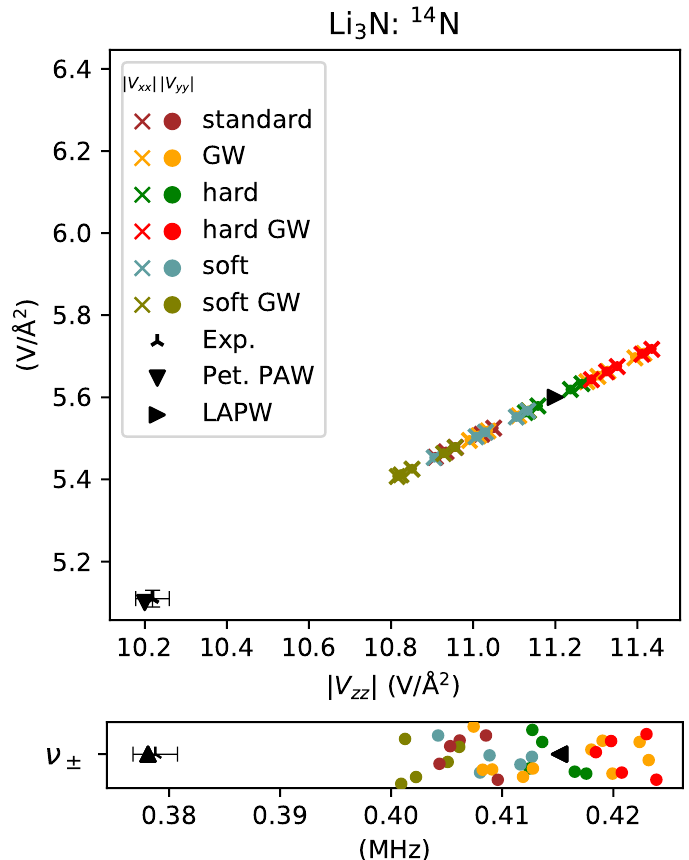
Figure 2. EFG plot for the 14 N sites in Li 3 N are shown at the top; the corresponding NQR frequencies are shown underneath. Since the system is symmetric, V xx = V yy = − V zz /2, only one frequency exists. Colored markers show a computed value for each PAW potential. Experimental data [40], shown as a three-pointed star, is close to these values, δ ≈ 10%, but lies outside their range. Literature data [16], shown in black, were calculated using both a PAW and LAPW method. The V zz value was computed to be